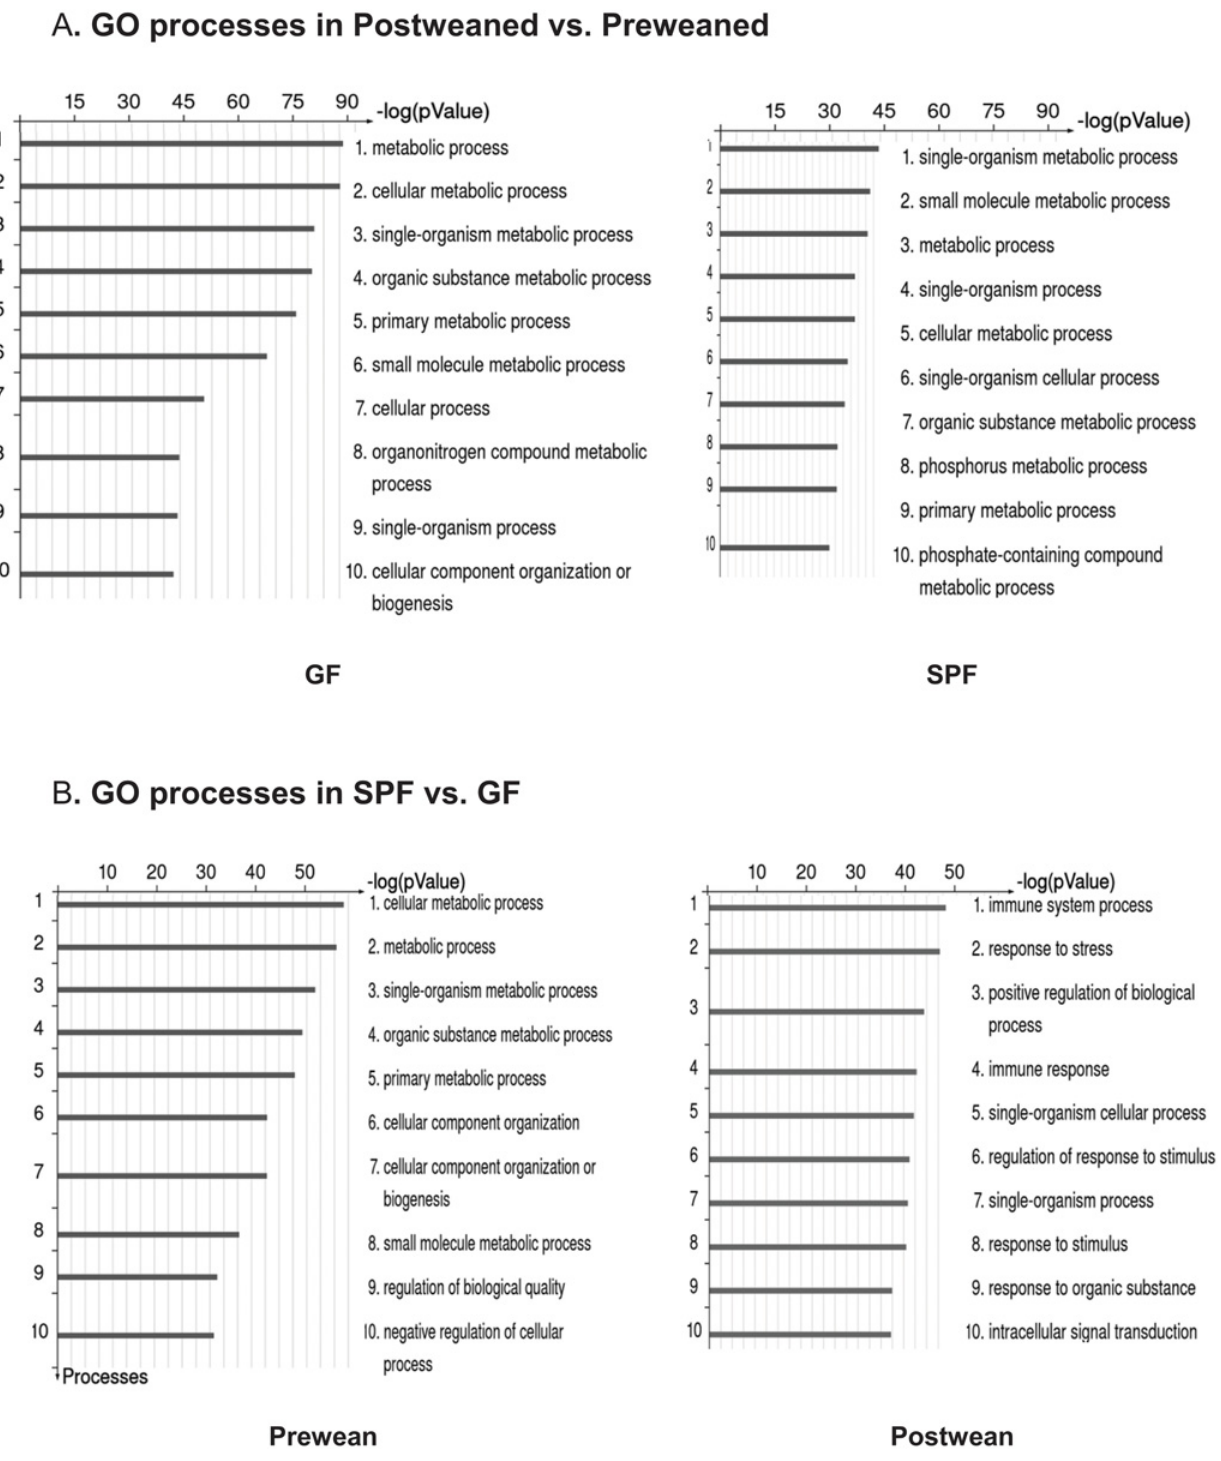
Fig 1. MetaCore gene enrichment analysis of ileum microarray data representing development- and microbial colonization- effects in GF and SPF mice. Differentially expressed genes (fold change (cid:1) ± 2) in SPF and GF ileum from preweaned (n = 2) and postweaned (n = 2) mice were subjected to gene enrichment analysis using GeneGo MetaCore software. Panel A: Development dependent genes; top 10 overrepresented gene ontology (GO) biological processes in GF and SPF ileum (post vs preweaned). Panel B: Microbiota dependent genes; top 10 overrepresented gene ontology (GO) biological processes in pre and postweaned ileum (SPF vs.